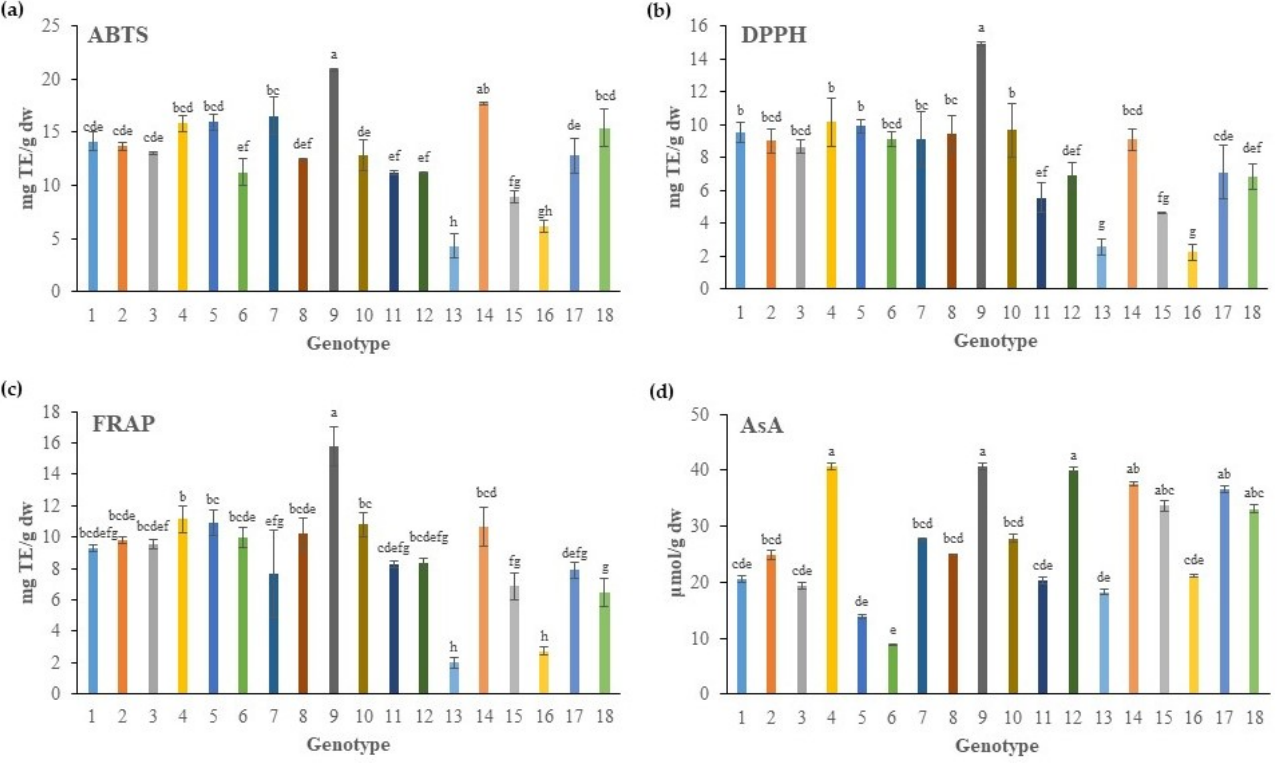
Figure 1. Overview of the antioxidant capacity of extracts derived from the aboveground portion of 18 native Greek rock samphire genotypes (Table 1) determined as 2,2-azino-bis-(3-ethylbenzothia- zoline-6-sulfonic acid) radical scavenging activity (ABTS) ( a ); 2,2-diphenyl-1-picrylhydrazyl radical scavenging activity (DPPH) ( b ); and ferric reducing antioxidant power (FRAP) ( c ); all values are expressed as mg of trolox equivelant (TE) per g of dry weight (dw). The content of ascorbic acid (AsA), expressed as μ mol of AsA per g of dw, is also shown ( d ). Data represent the mean values ± standard deviation. Different letters on the bars characterize significant differences among geno- types according to Tukey’s test for p ≤ 0.05.